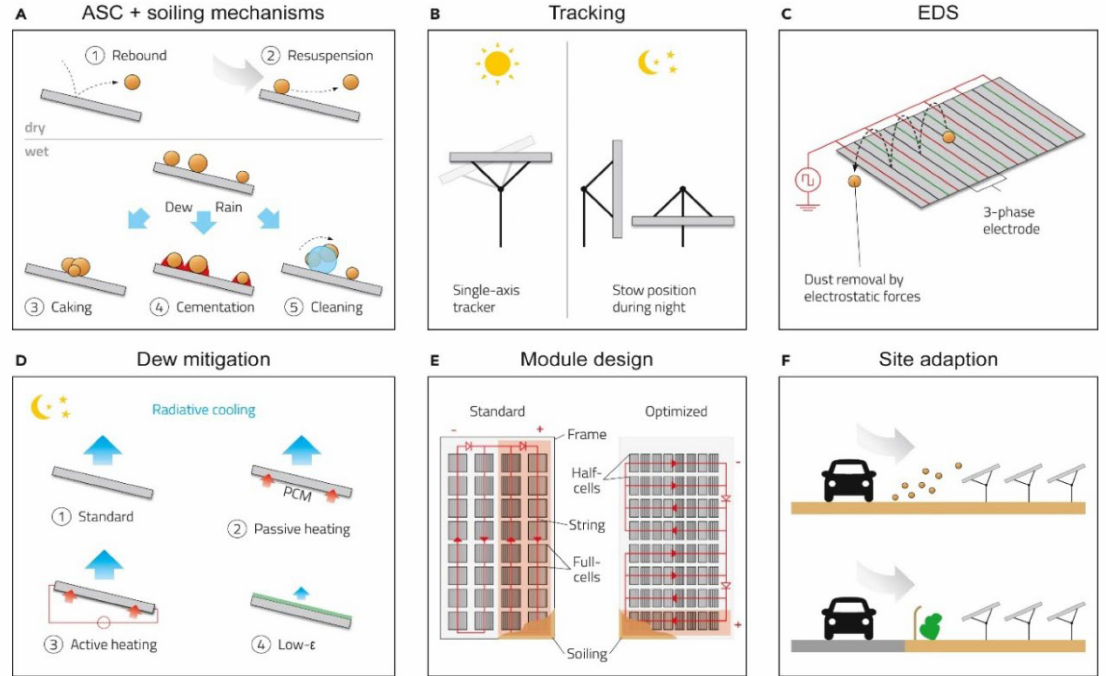
Figure 4. Schematic illustration of soiling mitigation technologies: ( A ) Important soiling mechanisms which could be addressed by anti-soiling coatings (ASCs). ( B ) Single-axis tracking and optimization of night stowing position. ( C ) Working principle of EDS (standing wave version). ( D ) Dew mitigation by low- ε coatings and active and passive heating. ( E ) PV module design approaches for soiling loss reduction: the red overlay indicates lost cell strings due to soiling. ( F ) Site adaption. Reproduced with permission from Ref. [44].